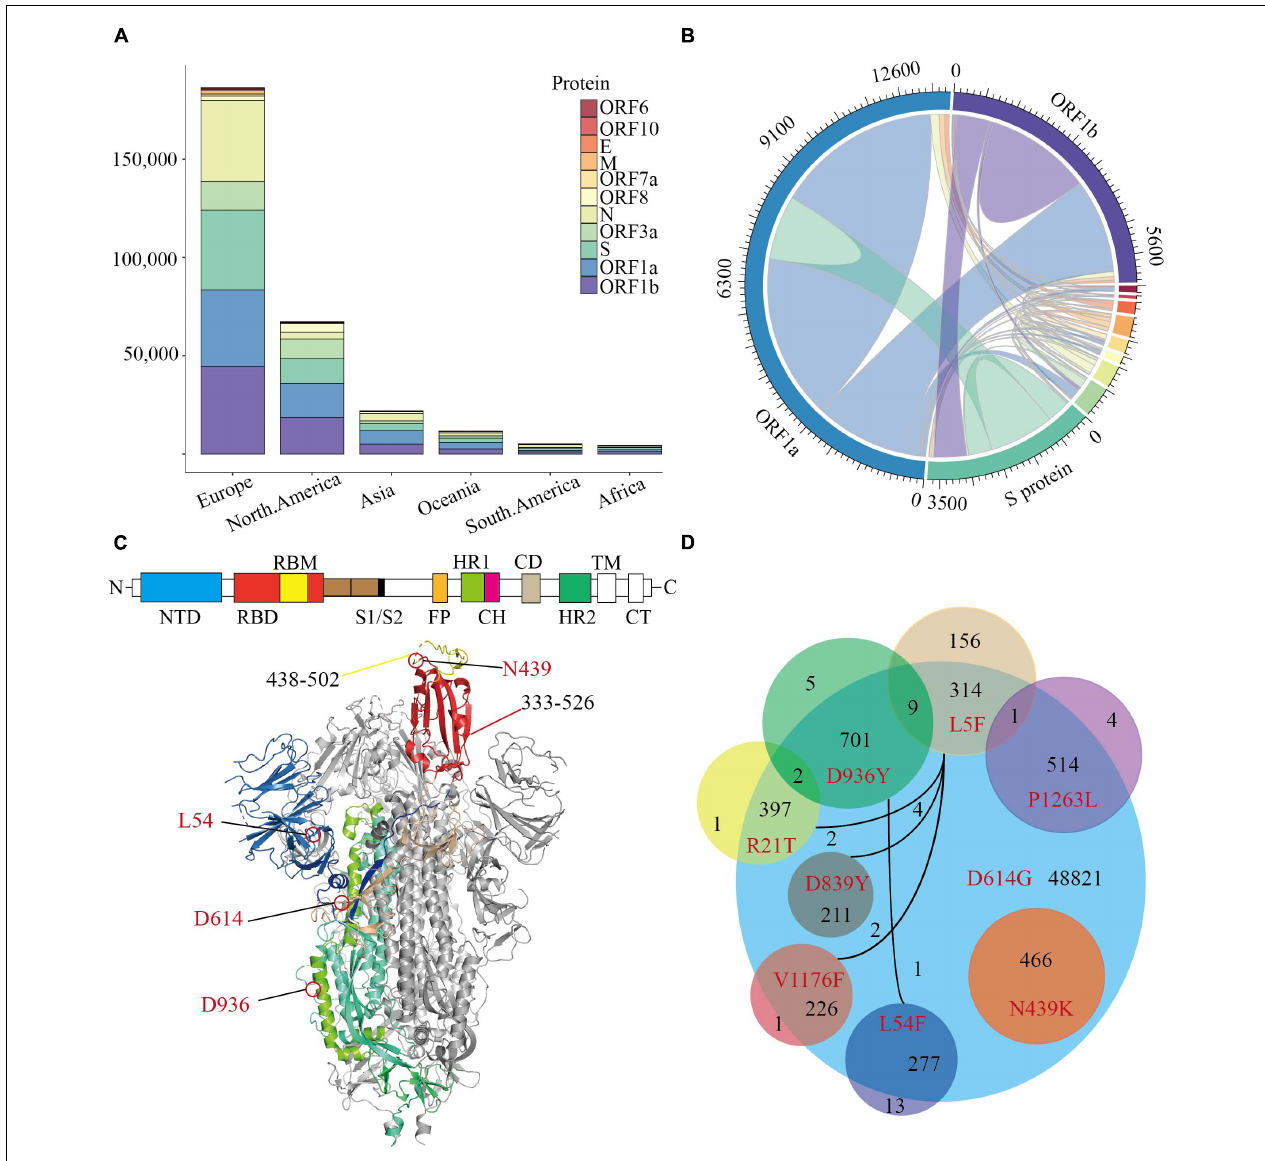
FIGURE 1 | The distribution of Missense Mutations in SARS-CoV-2. A stacked histogram shows all missense mutations of SARS-CoV-2 from different continents of the world. (B) A chord diagram shows the missense mutation shared between different proteins of SARS-CoV-2, and the color scheme is the same as that in (A) . (C) A topology and cartoon representation of SARS-CoV-2 homo-trimeric spike (S) glycoprotein (PDB ID: 6VSB). NTD, N-terminal domain; FP, fusion peptide; HR1, heptad repeat 1; CH, central helix; CD, connector domain; HR2, heptad repeat 1; TM, transmembrane region; CT, cytoplasmic tail; S1/S2, protease cleavage sites; Some important mutation sites and residue intervals were marked on the figure. (D) A Venn diagram of main amino acid mutation sites of the S protein, the number of mutations, and co-mutations were